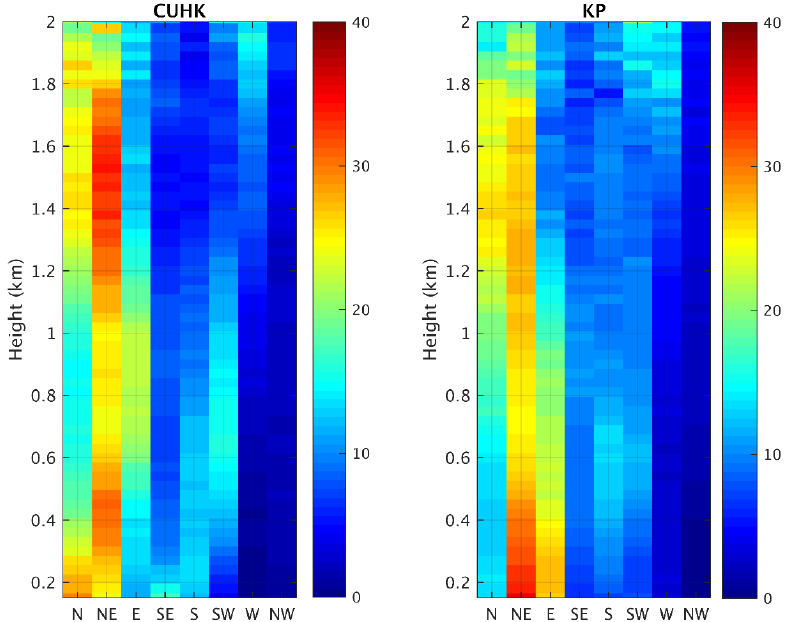
Figure 7. Annual vertical profiles of horizontal wind direction frequency at CUHK (left) and KP (right).